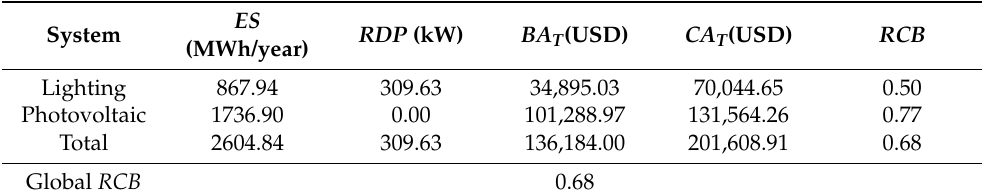
Table 11. Global Economic Analysis of the Project.